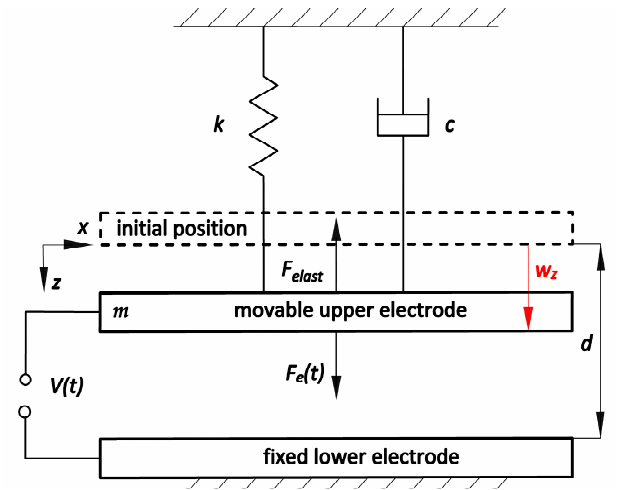
Figure 1. A 2D schematic of a parallel plate MEMS capacitor. A static situation is depicted here, where the elastic restoring force is in equilibrium with the external electrostatic force.